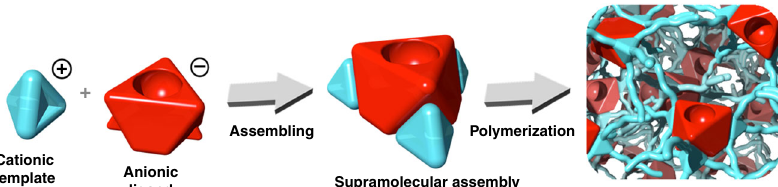
Fig. 1 Porous supramolecular assemblies. Schematic illustration of the formation of ion pair-directed supramolecular assemblies and their subsequent construction of